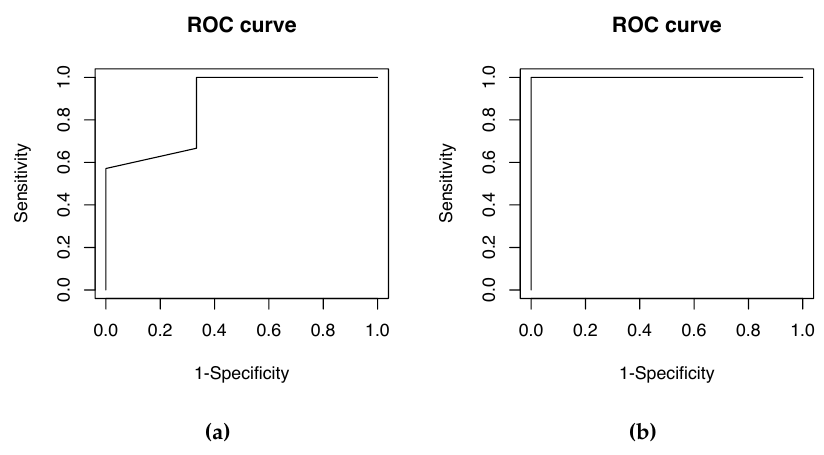
Figure 10. ROC curves. ( a ) ROC curve Success1; ( b ) ROC curve